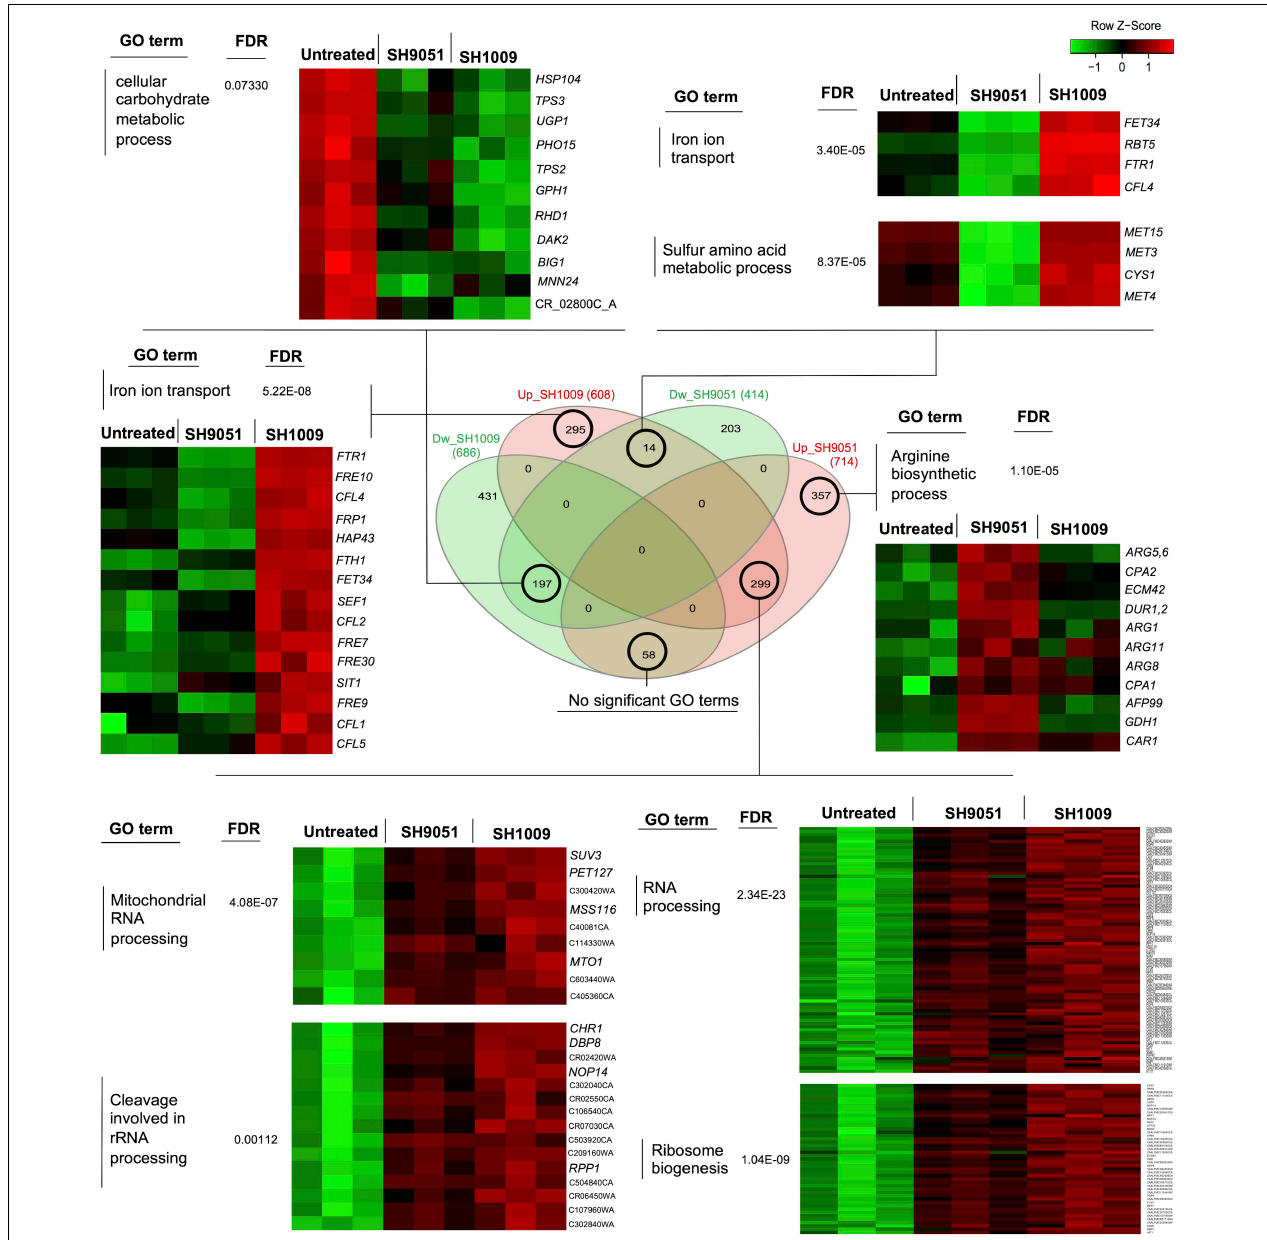
FIGURE 5 | Comparisons between induced and repressed transcriptomic profiles of aurones SH1009 and SH9051. The Venn diagram shows the number of commonly or uniquely dysregulated genes between four datasets: down-regulated-SH1009, down-regulated-SH9051, up-regulated-SH1009, and up-regulated-SH9051 dataset. Heatmaps demonstrate the differential gene expression of sets of genes that are clustered and enriched for significant GO terms in each overlap. The corrected P values (FDR) are indicated for each GO term. The heatmaps were generated to visualize the comparisons of differential gene expression across the SH1009- and SH9051-treated and untreated samples using the shinyheatmap tool by which the expression of genes were scaled per row based on the Z -score of standard deviations (positive or negative) and plotted on a red–green color scale where the high level of expression is colored red and the low level of expression is colored